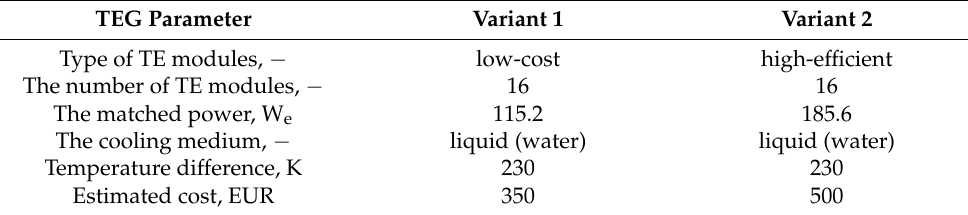
Table 3. The essential parameters of thermoelectric generators assumed by economic